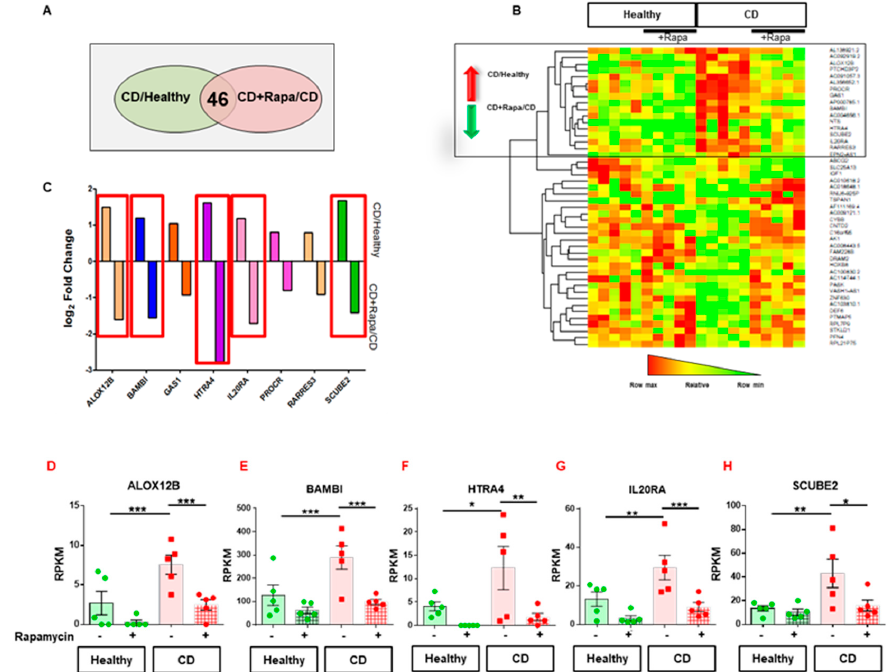
Figure 3. Rapamycin impacts on the CD HILEC transcriptomic state. ( A ) Venn diagram showing genes shared between the indicated groups. ( B ) Heatmap showing the 46 genes concomitantly upregulated in CD versus healthy HILECs and downregulated by rapamycin. ( C ) Bar graphs showing the fold change (log 2 FC) of the indicated genes in CD versus healthy HILECs and in CD + rapamycin versus CD HILECs. D–H. Scatter plots with bars showing Reads Per Kilobase Million (RPKM) variations at the indicated conditions of ALOX12B ( D ), BAMBI ( E ), HTRA4 ( F ), IL20RA ( G ), and SCUBE2 ( H ). N = 5/group. Data are represented as mean ± s.e.m. * ≤ 0.05, ** ≤ 0.01, *** p ≤ 0.005. By hierarchical clustering of these 46 genes, we identified a group of genes upregulated in CD versus healthy HILEC that decreased after rapamycin treatment, which might be targeted to modulate lymphatic functions, such as leukocyte transmigration (Figure 3B). Among them, we selected a set of protein-encoding transcripts (Figure 3C) showing Reads Per Kilobase Million RPKM ≥ 1, a log 2 fold change (FC) ≥ 1 for CD versus healthy HILEC, and a concomitant log 2 FC ≤ − 1 for rapamycin-treated CD HILECs versus CD HILECs. Transcripts displaying these features were ALOX12B, BAMBI, HTRA4, IL20RA , and SCUBE2 (Figure 3D–H). Of note, the expression of these genes was not affected by rapamycin treatment in healthy HILECs, pointing out them as targets specific for CD cells.